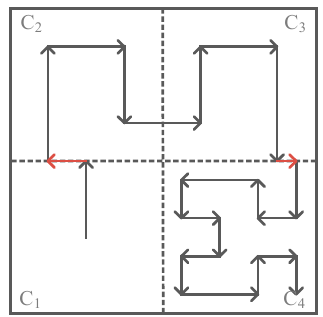
Figure 4. An example of an adjustable trajectory based on node density in specific subareas.